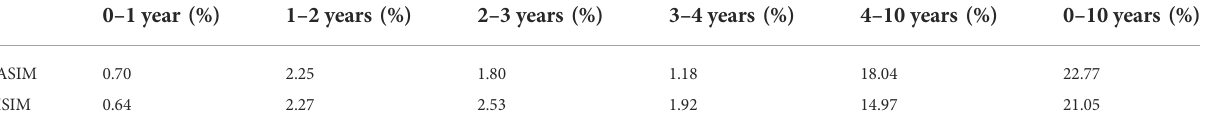
TABLE 4 Reservoir gas content decline rate with ASIM and